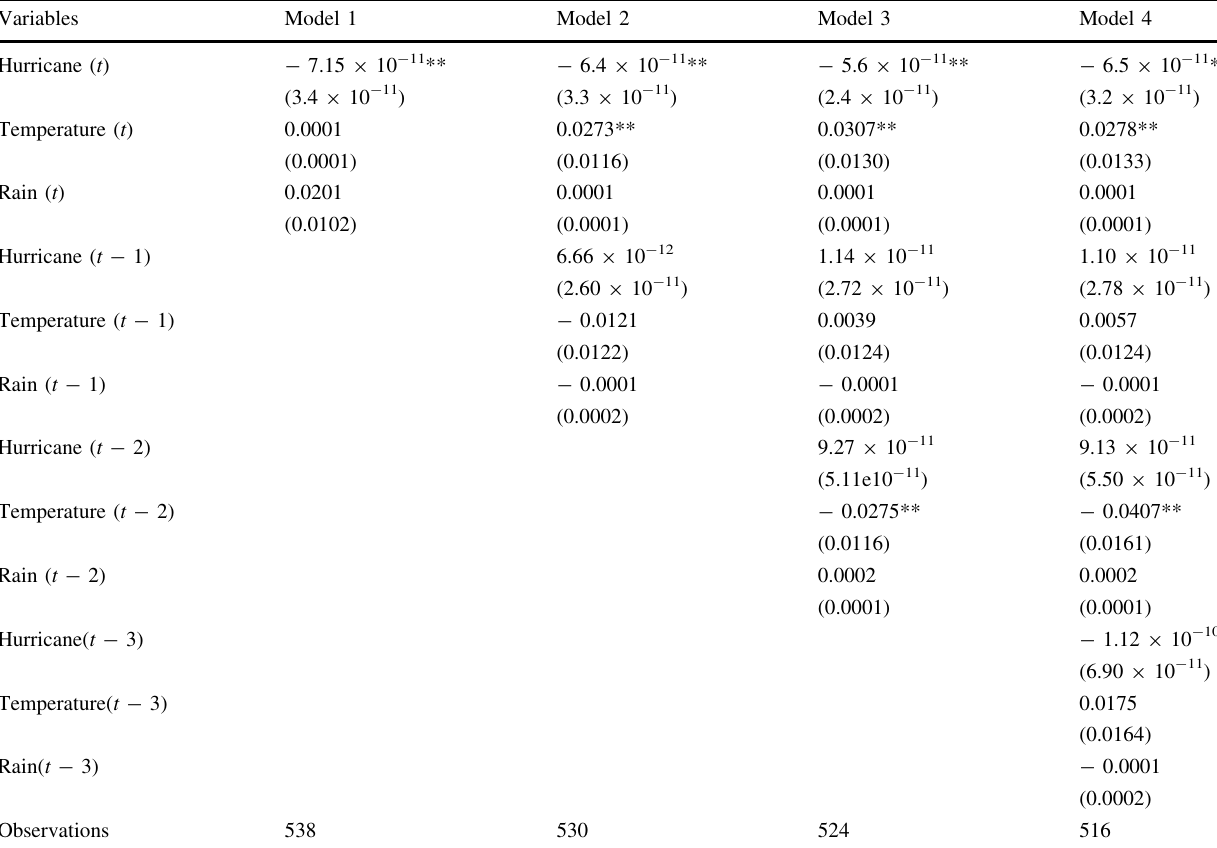
Table 4 Impact of hurricanes on production efficiency in the 17 Caribbean countries in the case